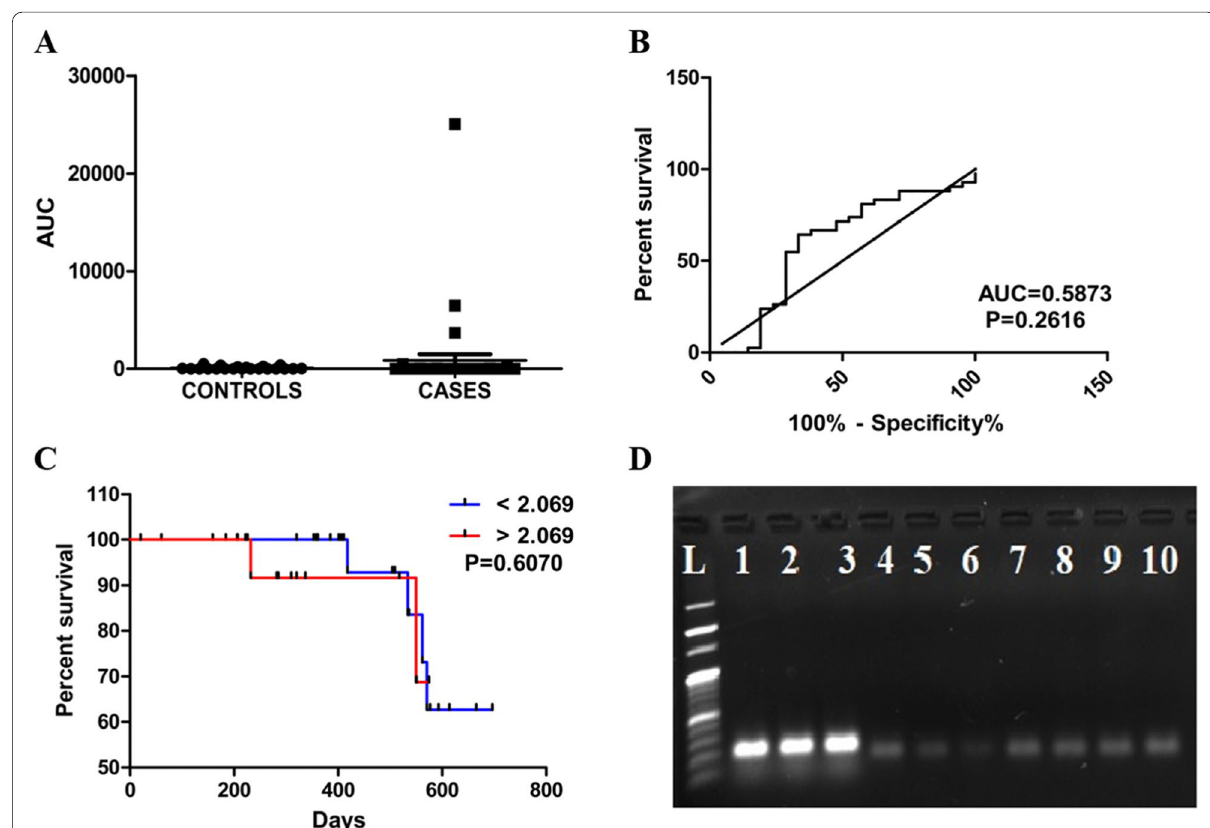
Fig. 2 A Scatter plot graph with PRAME gene expression in cases and controls. B Receiver operating curve (ROC) for the PRAME gene obtained from the RT-qPCR. C Kaplan-Meier plot of overall survival in AML patients according to PRAME gene expression. D Electrophoresis representation of PRAME gene expression and B-actin expression in acute leukemia patients. L